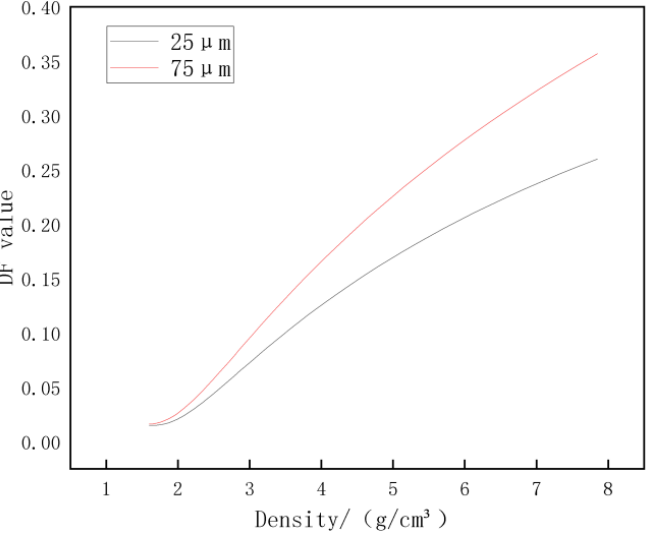
Figure 6. E ff ect of particle size and density on particle distribution under vibration. Figure 6. Effect of particle size and density on particle distribution under